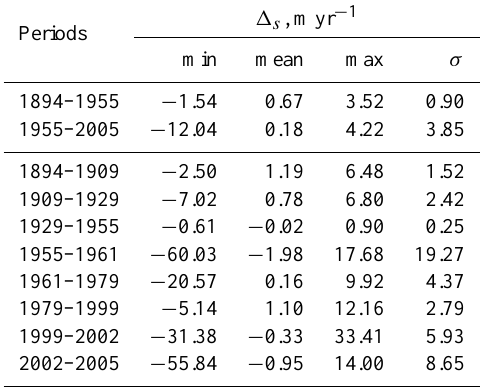
Table 2. Minimum, mean, maximum changes and standard devia- tion ( σ) for rate of change in coastline position ( 1 s ) by